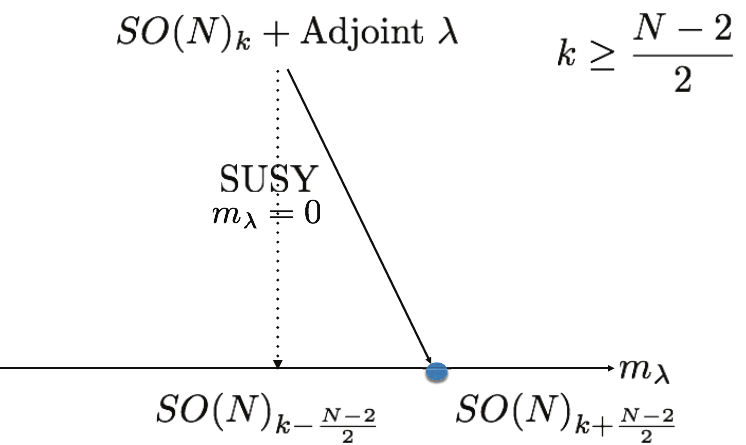
Figure 11: The phase diagram for SO ( N ) gauge theory with an adjoint fermion k for k ≥ ( N − 2 ) / 2. The physics at the supersymmetric point is smooth. For k = ( N − 2 ) / 2 the negative mass phase is trivial. In that case the transition is still to the right of the supersymmetric